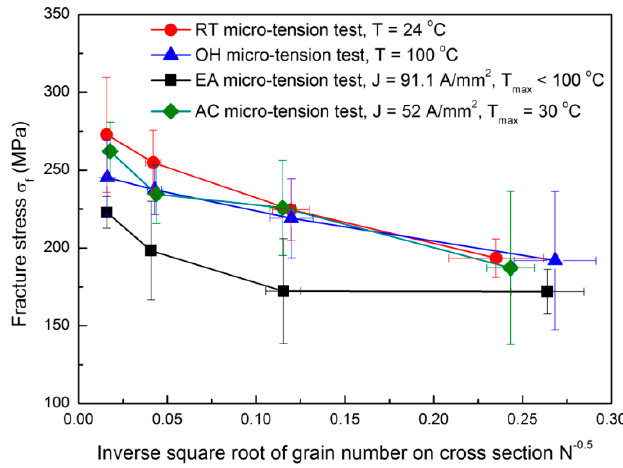
Figure 3. The fracture stress behavior for the different tested configurations.